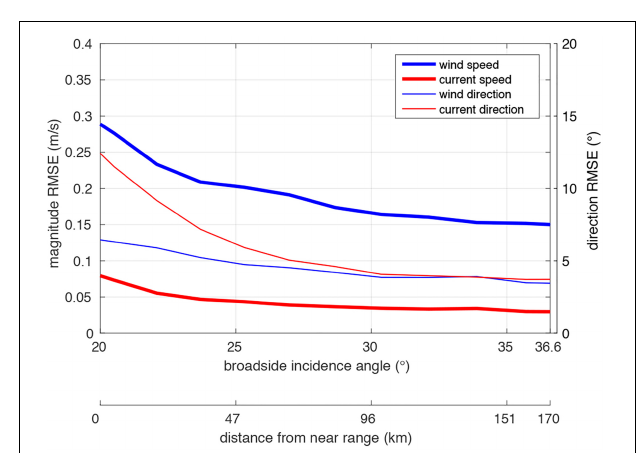
FIGURE 2 | SEASTAR root-mean-square error (RMSE) for current (red) and wind (blue) speed (thick lines) and direction (thin lines) across a 170 km swath based on numerical Monte-Carlo simulations for a wind speed of 8 m/s and a current speed of 0.6